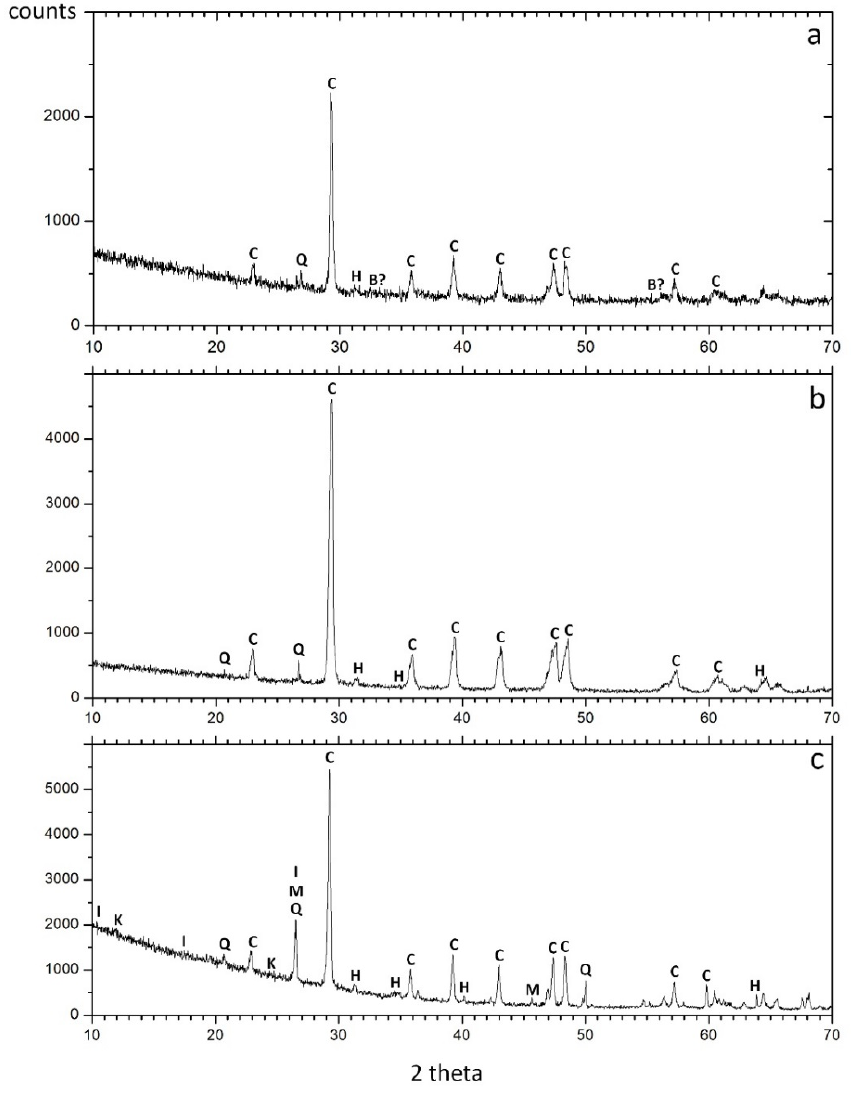
Figure 7. XRD pattern registered on the black pigmented area (sample S7) ( a ), on the yellow pigmented area (sample S6) ( b ), and on the coarse plaster layer (sample S9) ( c ). Identified mineral phases are marked as follows: C—calcite; Q—quartz; H—hematite; K—kaolinite; M—muscovite; I—illite; B—braunite.